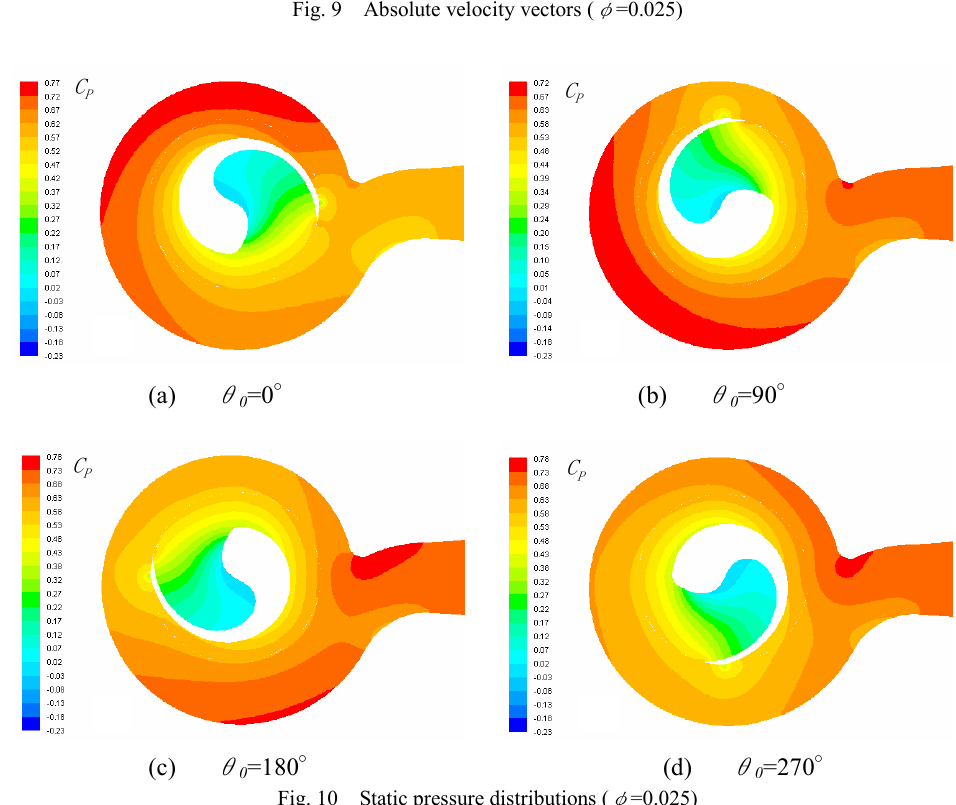
Fig. 10 Static pressure distributions ( φ